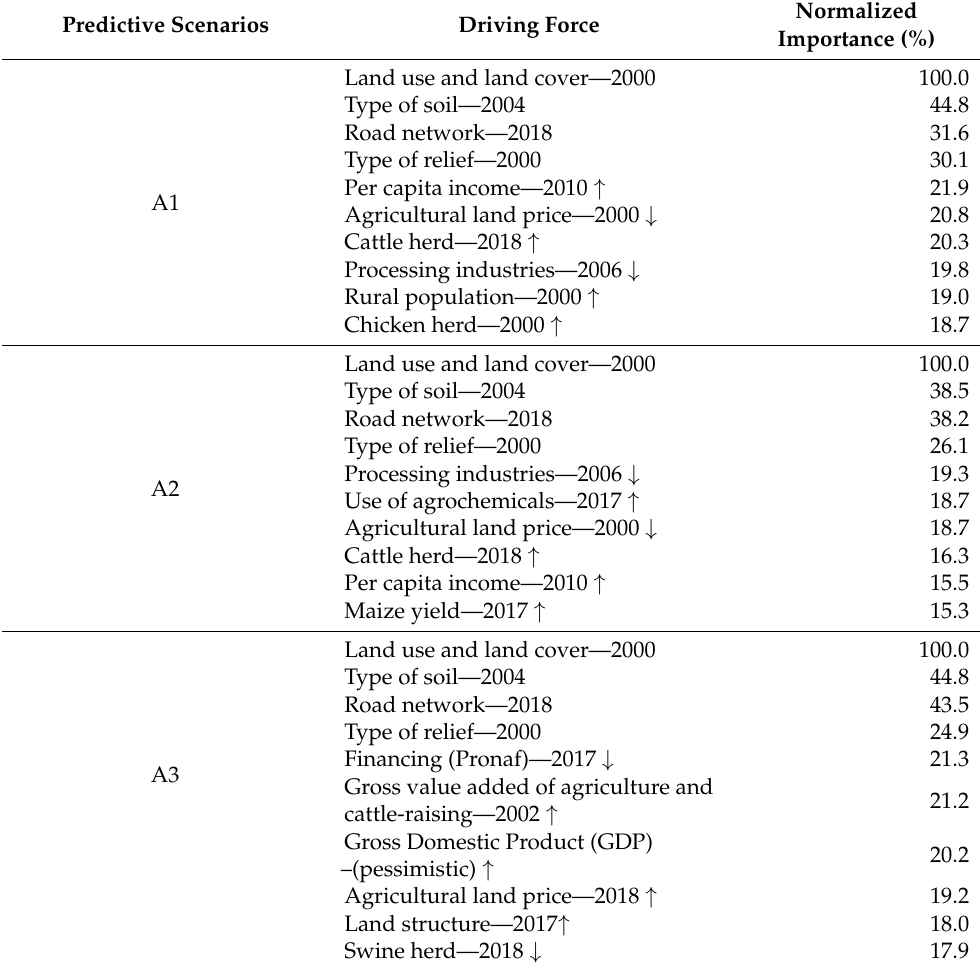
Table 9. The ten most important driving forces in predictive scenarios A. Predictive Scenarios